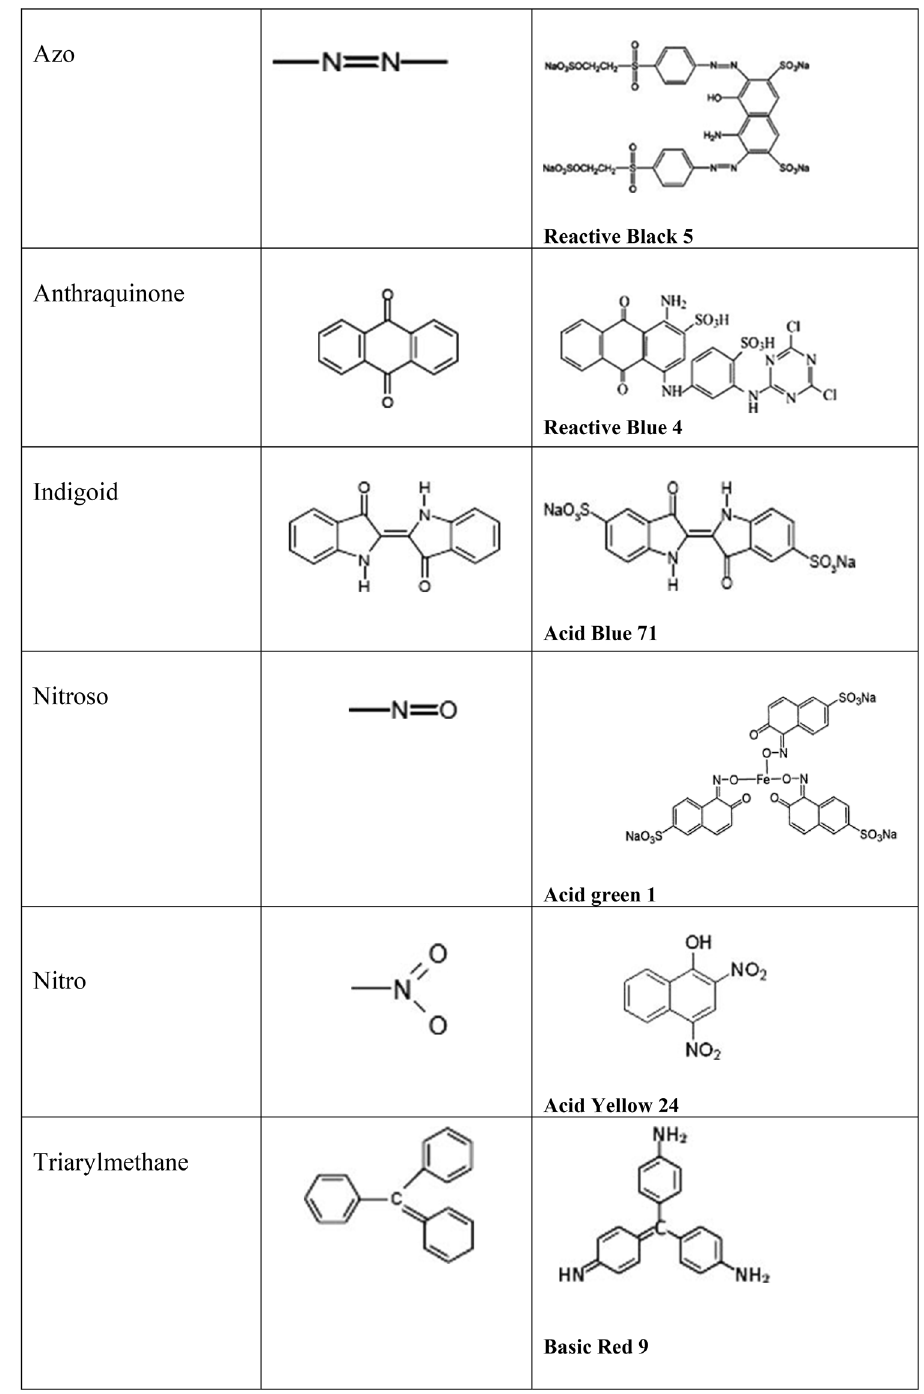
Table 1 Classification of dyes according to their chemical structure. Source : adapted from